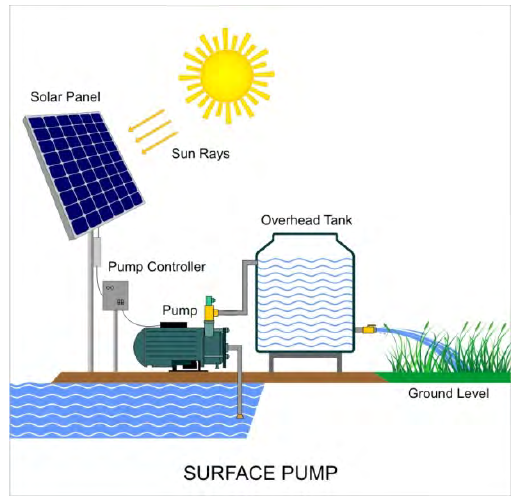
Figure 3. Solar power water pump (Source: Nicholls, 2006).